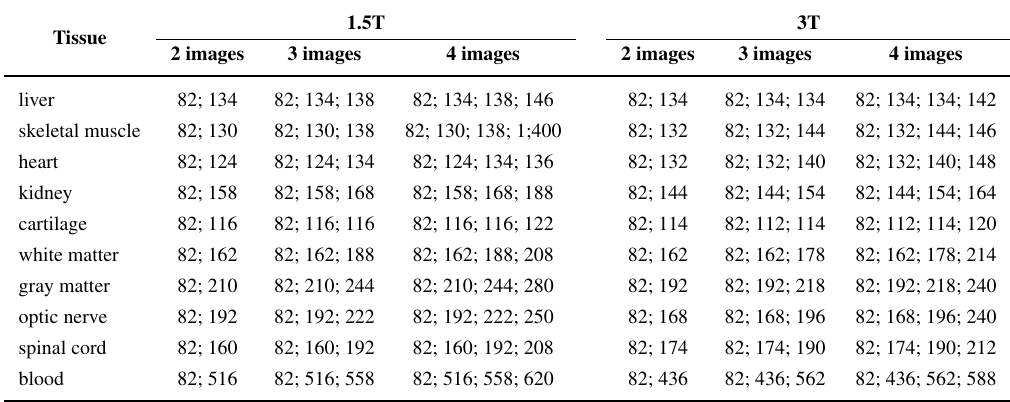
Table 2. Optimal echo times T of acquisitions at 1.5 T and 3 T.